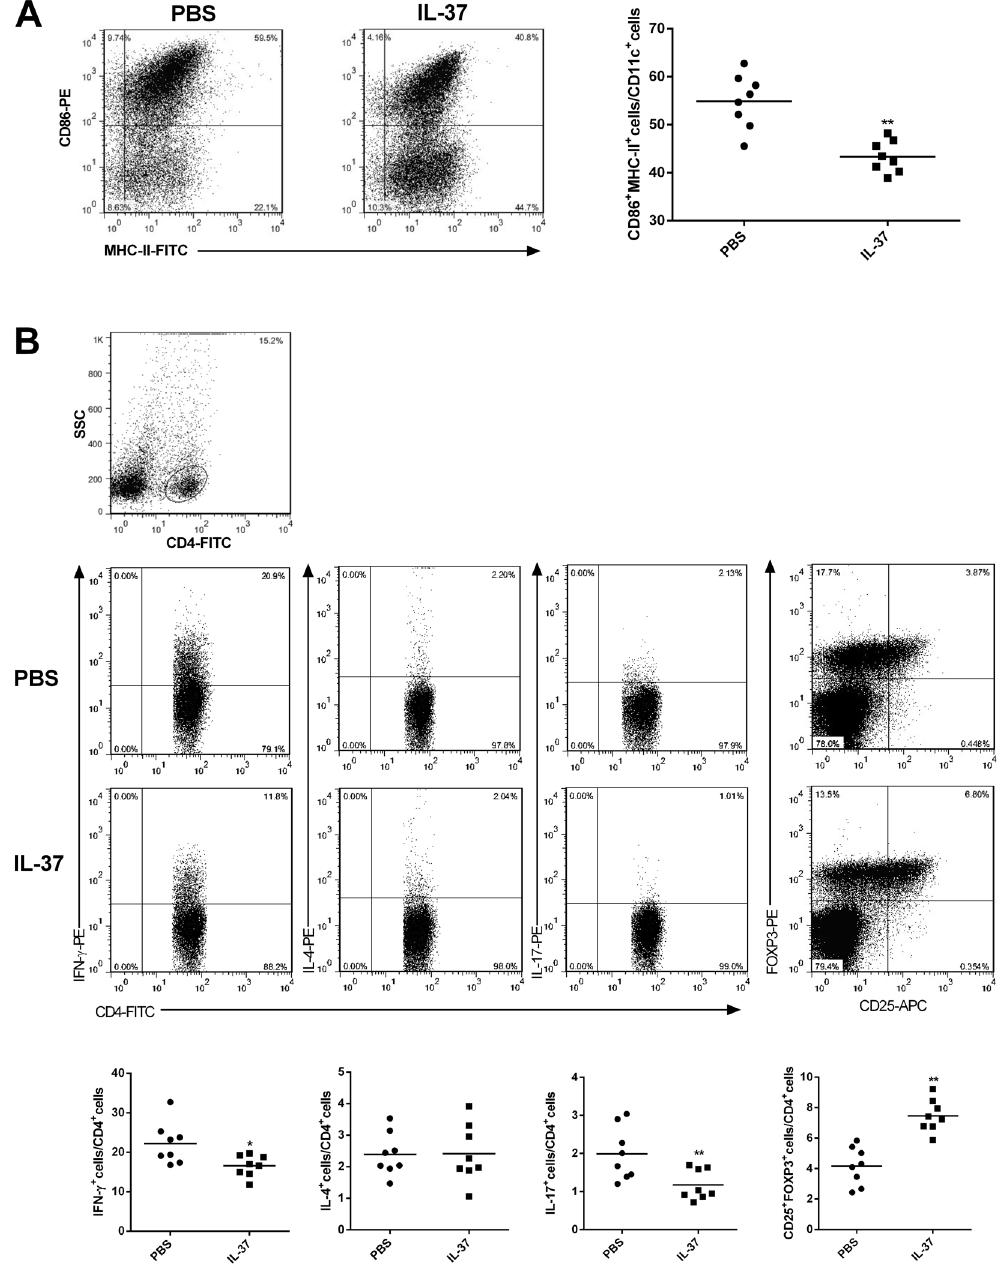
Figure 3. Effect of IL-37 administration on DCs and CD4 + T cells in spleen of ApoE − / − mice. ( A ) Flow cytometry results of DCs (CD86 + MHC-II + CD11c + ) are shown. The numbers in upper right quadrants indicate positive percentages of these cells. Results of statistical analysis of DCs. ( B ) Flow cytometry results of Th1 (CD4 + IFN- γ+ ), Th2 (CD4 + IL-4 + ), Th17 (CD4 + IL-17 + ), and Tregs (CD4 + CD25 + FOXP3 + ) are shown. The numbers in upper right quadrants indicate positive percentages of these cells. Results of statistical analysis of Th1 cells, Th2 cells, Th17 cells, and Tregs. Values are presented as the means ± SEM, n = 8. * p < 0.05, and ** p <